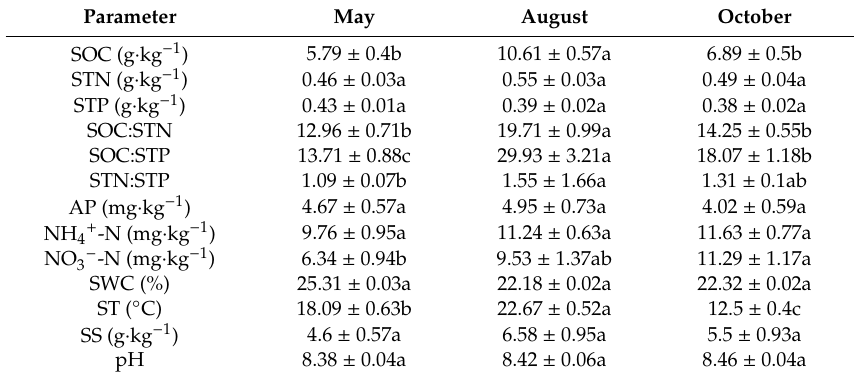
Table 5. Soil nutrient contents, temperature, moisture, salinity and pH across the season within the study